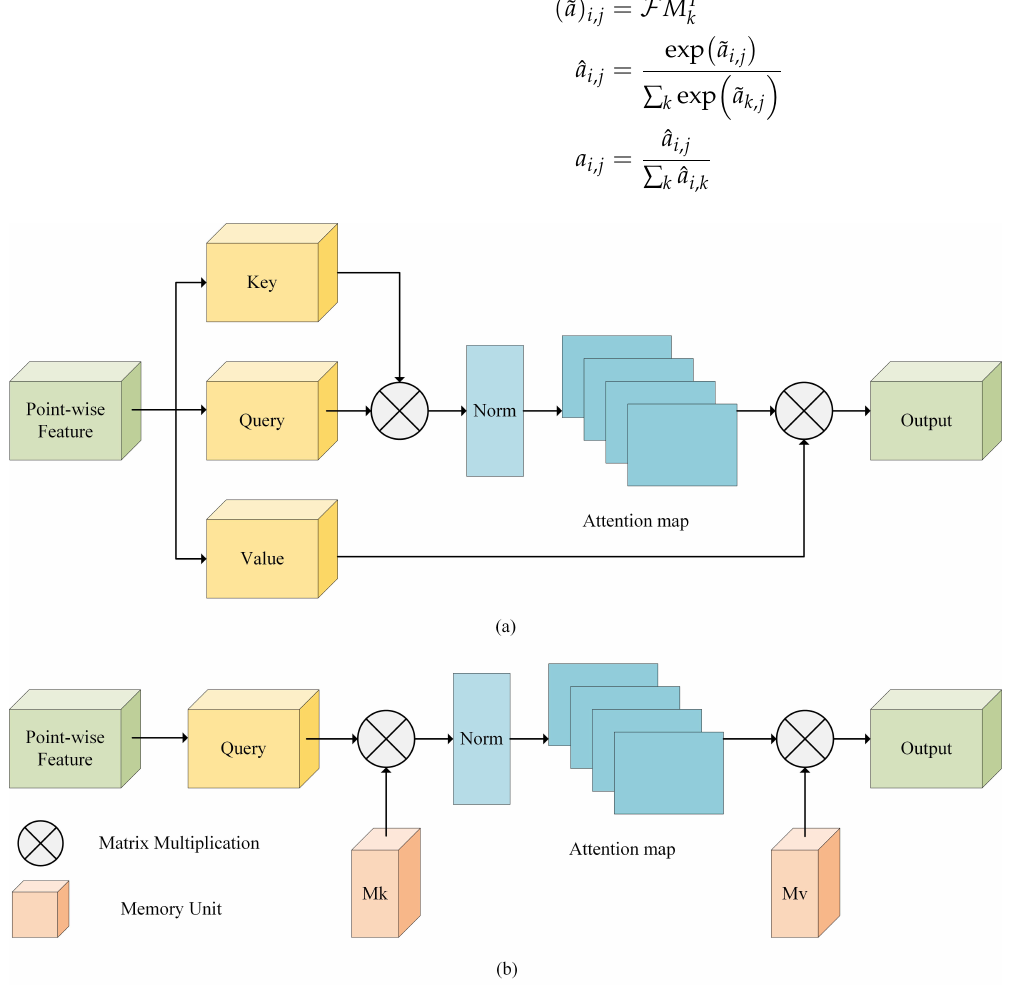
Figure 2. Illustration of the point cloud external attention module. ( a ) Self-attention. ( b ) External attention. The difference is that external attention uses a memory unit M as a memory of the whole training dataset, which is independent of the